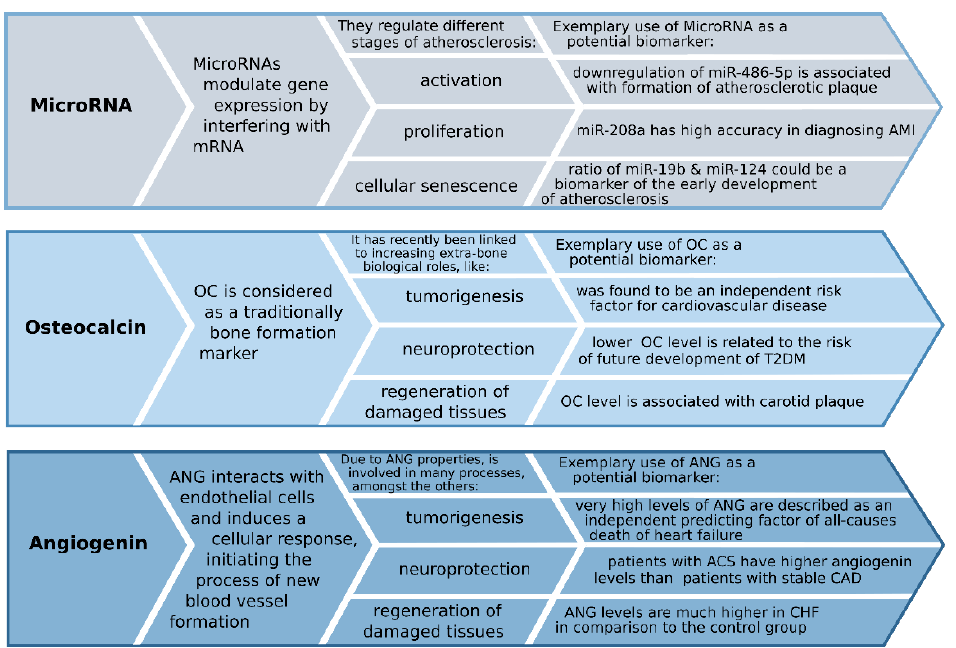
Study Biomarker